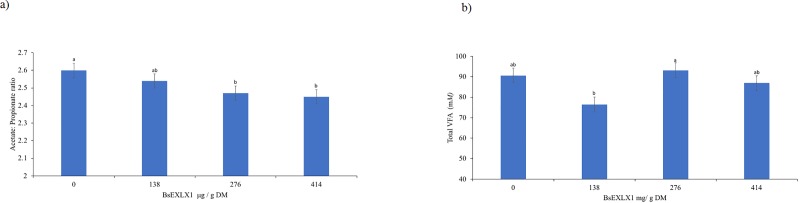
a and b. Effect of a recombinant expansin-like protein, BsEXLX1, on a) acetate: propionate ratio, polynomial contrast showed a linear effect of dosing BsEXLX1 (P < 0.01). b) Total VFA concentration of a diet for dairy cows. Different letters on bars indicate differences (P < 0.05), polynomial contrast showed a quadratic effect of dosing BsEXLX1 (P < 0.05). Error bars indicates SEM (Experiment 5).